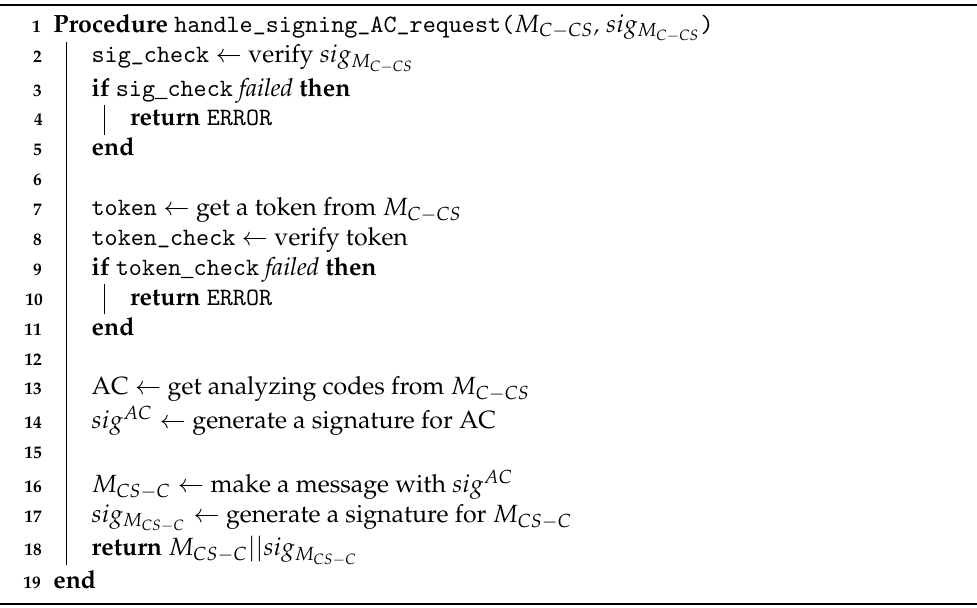
Algorithm 4: The code signing algorithm on the CS